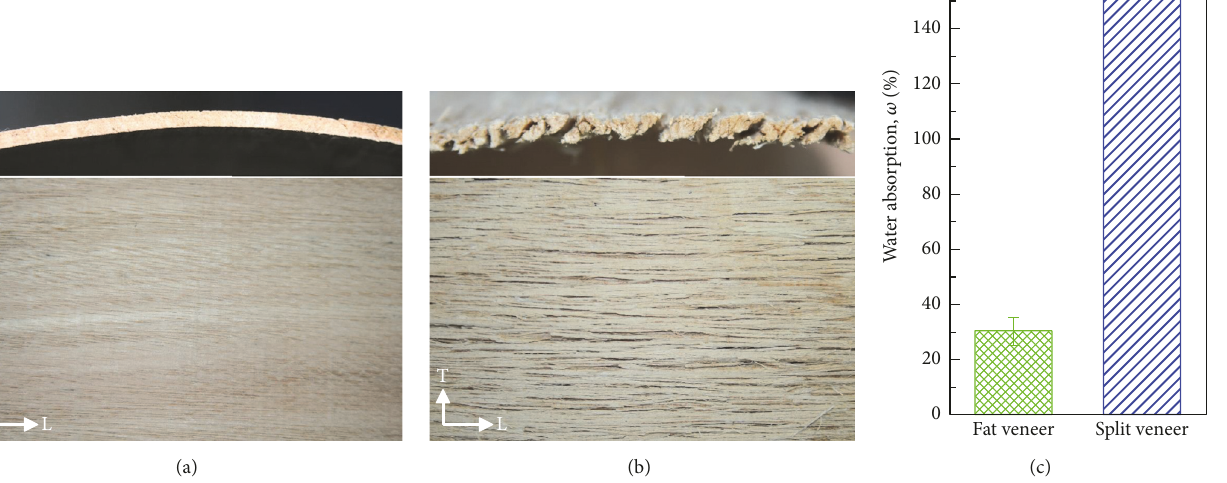
Figure 2: Surface macrograph of (a) the flat veneer and (b) OWFM, and their water loading rates.